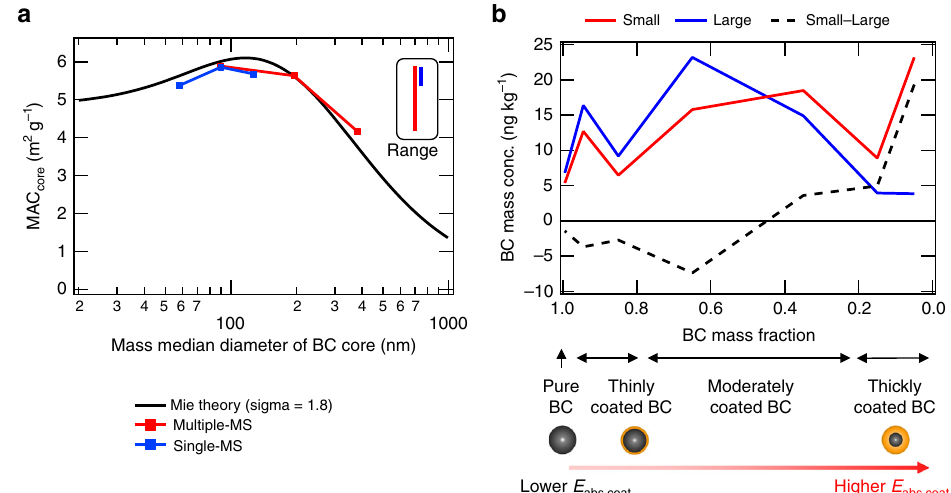
Fig. 5 Key variables for the high sensitivity in black carbon direct radiative effect. a Size dependence of the mass absorption cross section of black carbon (BC) core (MAC core , Eq. (2)) for the Multiple-mixing-state and Single-mixing-state representations. Squares correspond to the Small-size, Base-size, and Large-size simulations (at the surface). Black line shows theoretical calculations (using the algorithms of Bohren and Huffman 68 based on the Mie theory) assuming lognormal size distributions (sigma = 1.8). The ranges of MAC core are shown by red (Multiple-mixing-state) and blue (Single-mixing-state) vertical bars. b BC mixing state distributions of BC mass for the Small-size (red) and Large-size (blue) simulations in the Multiple-mixing-state representation (at the surface). BC particles are gradually shifted to the right by aging processes in the